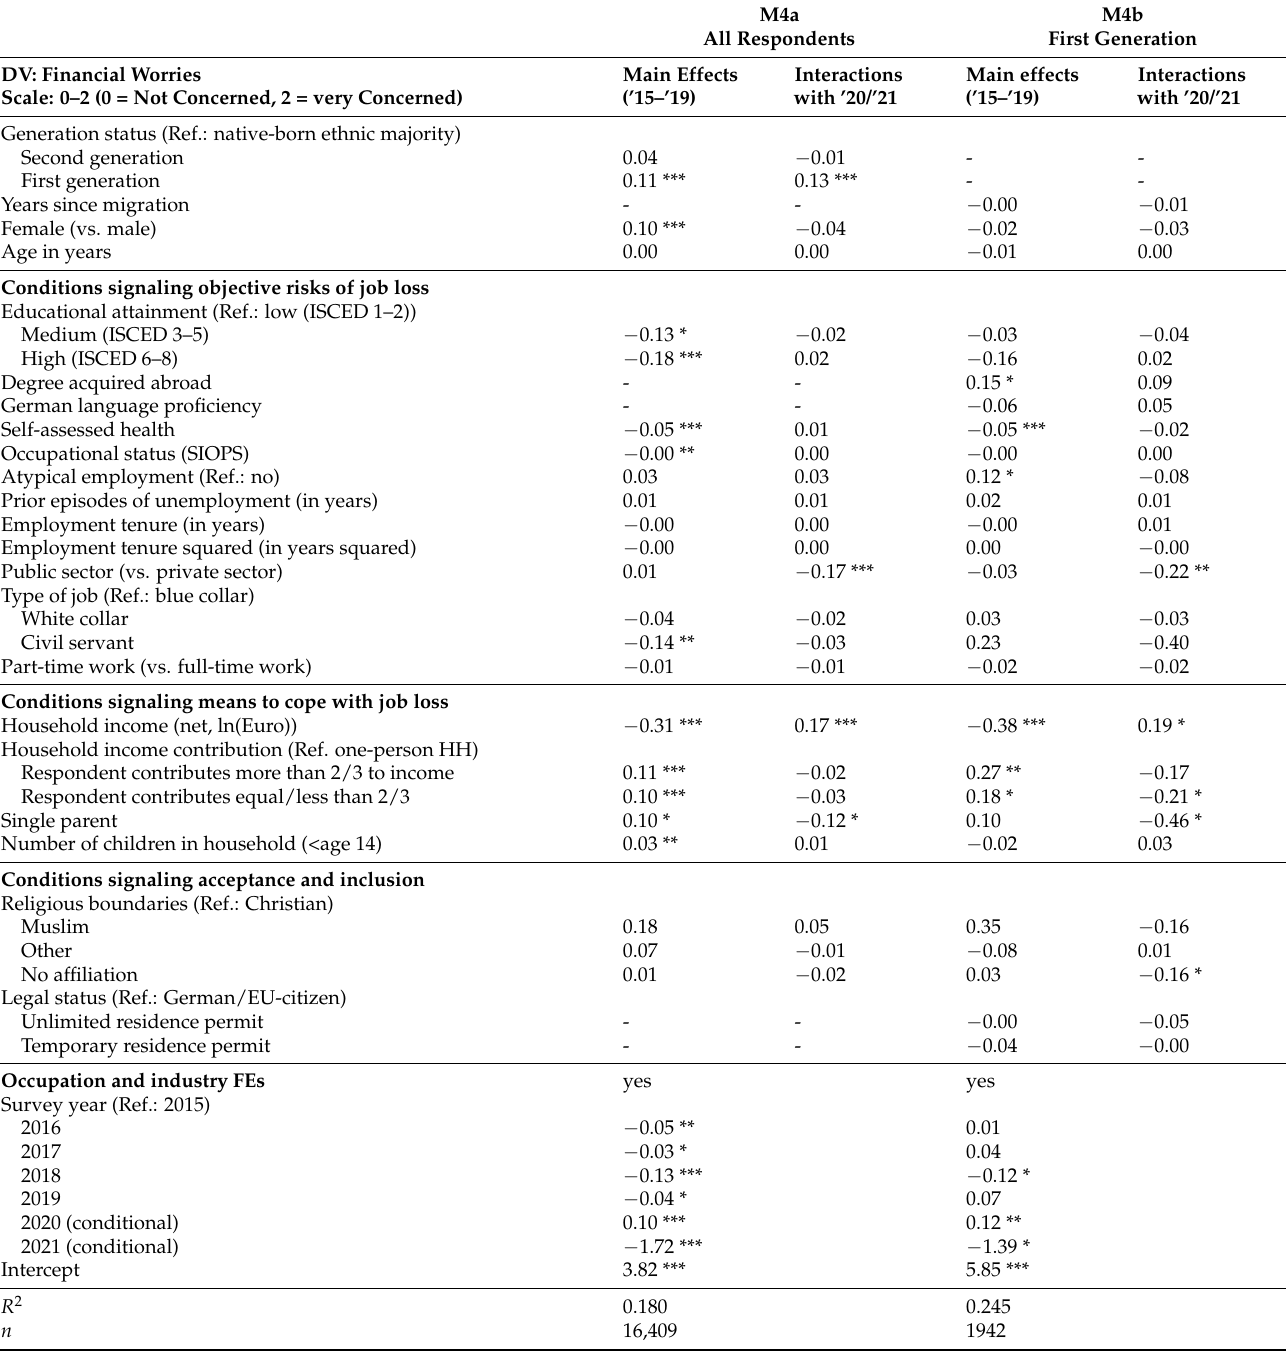
Table 2. Linear regressions, financial worries, 2015–2021.